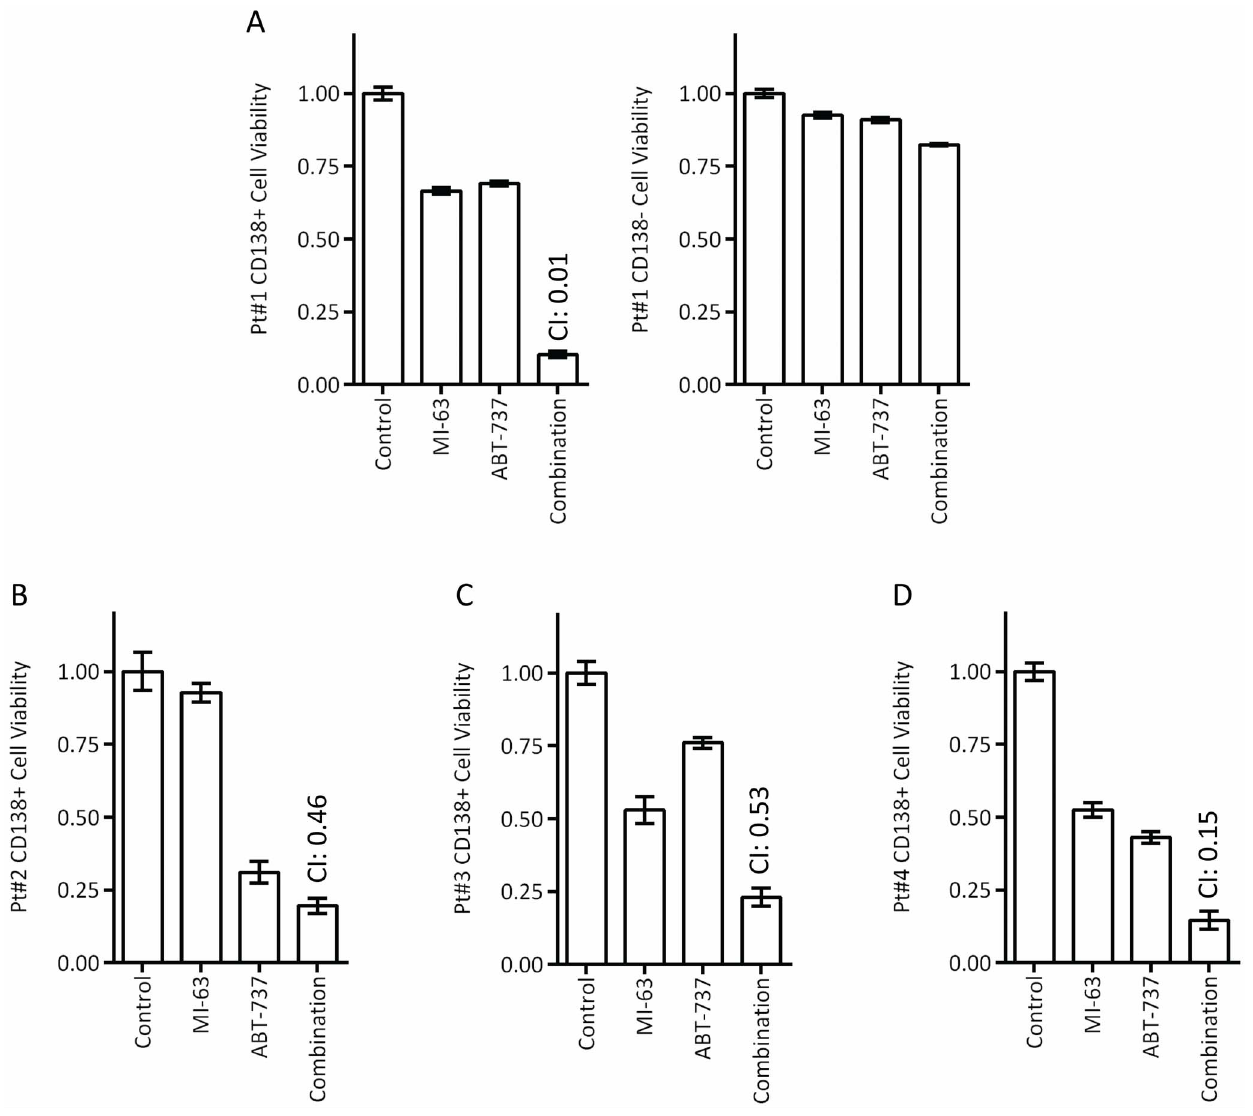
Figure 6. Combination studies in primary patient samples. A. The combination of MI-63 and ABT-737 was studied against CD138 + primary plasma cells from a patient with multiple myeloma (left panel), and CD138 2 marrow cells (right panel). Note that multiple doses of each drug were used for this experiment to calculate combination indices, with one representative condition shown. B–D. Additional primary plasma cells isolated from unique patients were exposed to the combination of MI-63 and ABT-737.